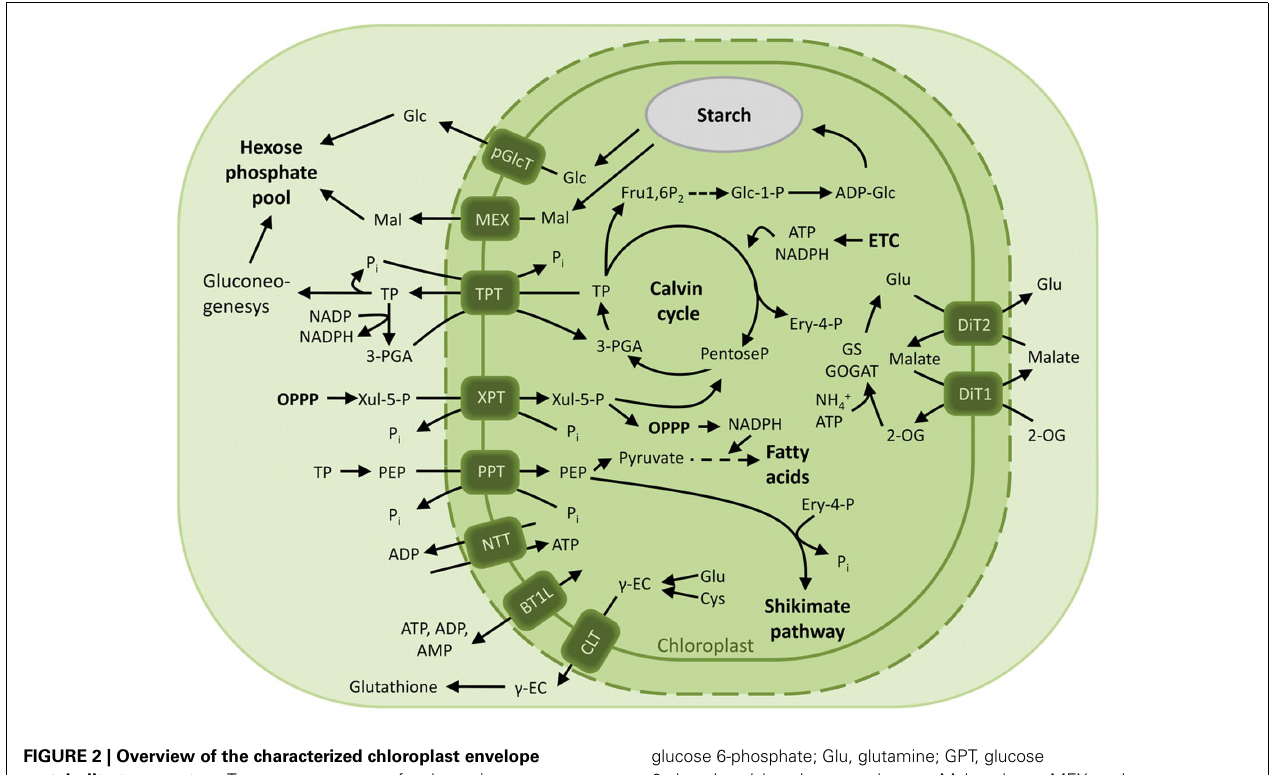
glucose 6-phosphate; Glu, glutamine; GPT, glucose 6-phosphate/phosphate translocator; Mal, maltose; MEX, maltose exporter; NTT, nucleoside triphosphate transporter; OPPP, oxidative pentose phosphate pathway; 3-PGA, 3-phosphoglyceric acid; PEP, phospho enol pyruvate; pGlcT, plastidic glucose transporter; Pi, inorganic phosphate; PPT, PEP/phosphate translocator;TP, triose phosphate;TPT, triose phosphate/phosphate translocator; XPT, xylulose 5-phosphate/phosphate translocator; Xul 5-P, xylulose